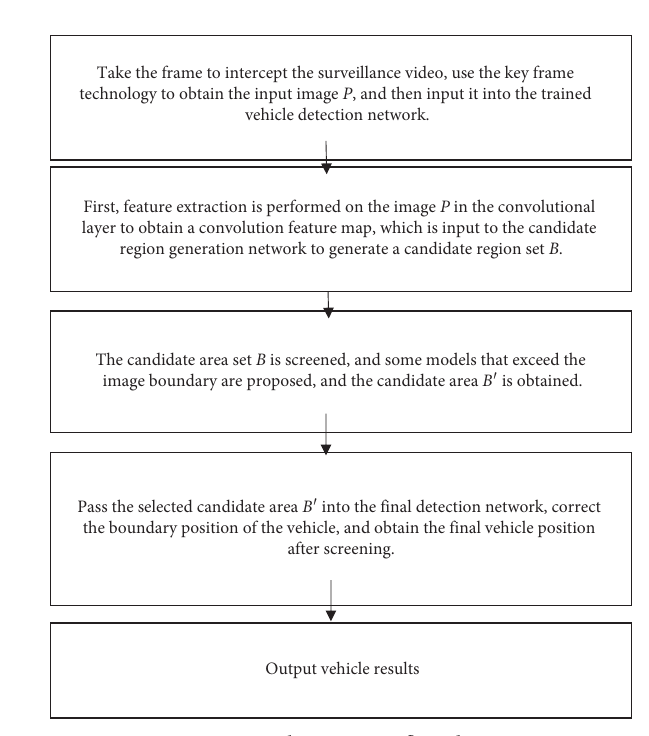
Figure 10: System implementation flow-detection